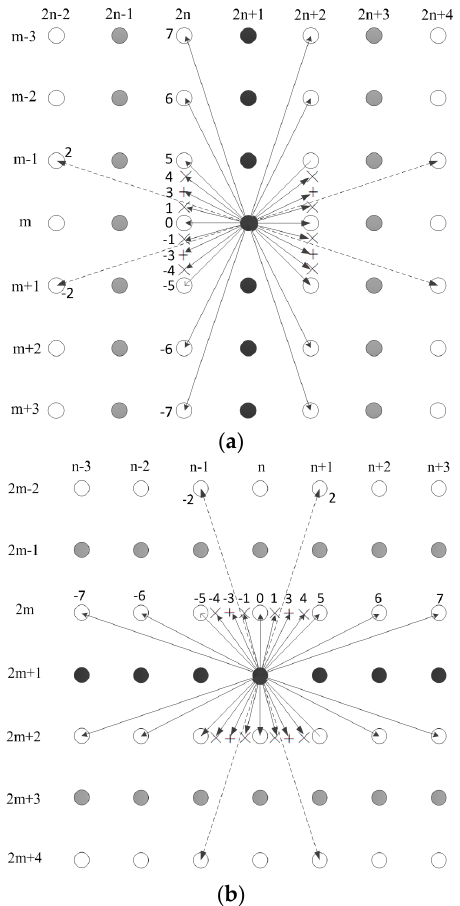
Figure 3. Set of reference directions of directional lifting-based wavelet transform. ( a ) Horizontal transform and ( b ) vertical transform.